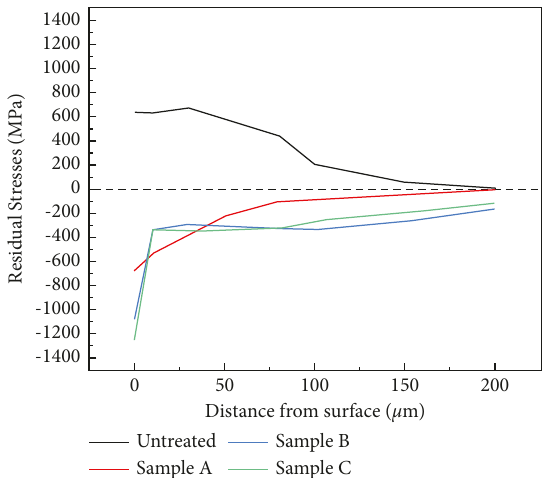
Figure 7: Residual stress depth profiles for the untreated and ion- nitrided